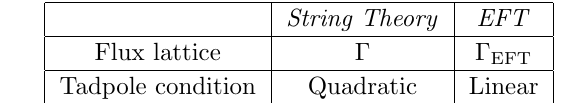
Table 1 . Main di(cid:11)erence between the string theory and the 4d EFT perspectives. For each region of (cid:12)eld space in the string theory construction a di(cid:11)erent sublattice (cid:0) EFT (cid:26) (cid:0) may be selected, but the linear dependence of the tadpole condition on the EFT (cid:13)uxes applies to all of them.